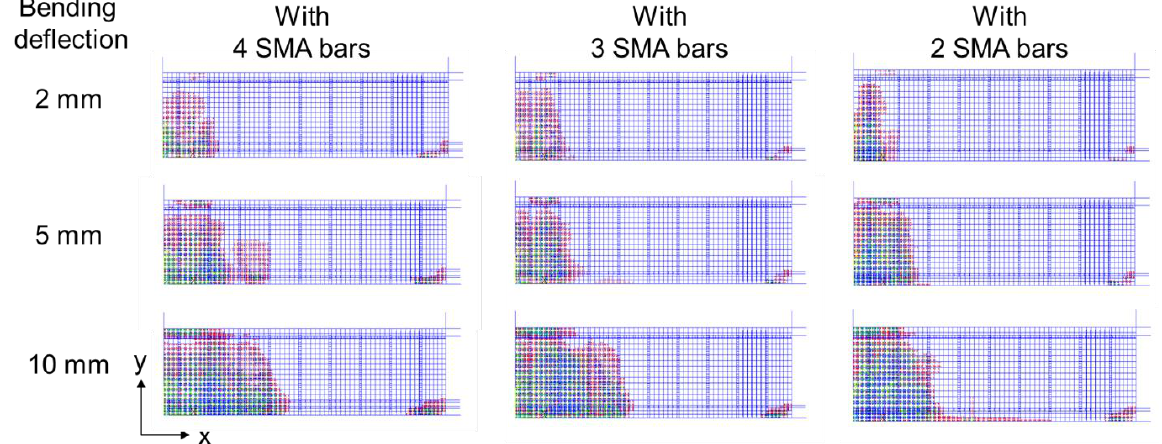
Figure 15. Concrete cracking and crushing patterns on x - y plane developed during RC beam bending, with activated 4, 3 and 2 Fe-SMA bars.